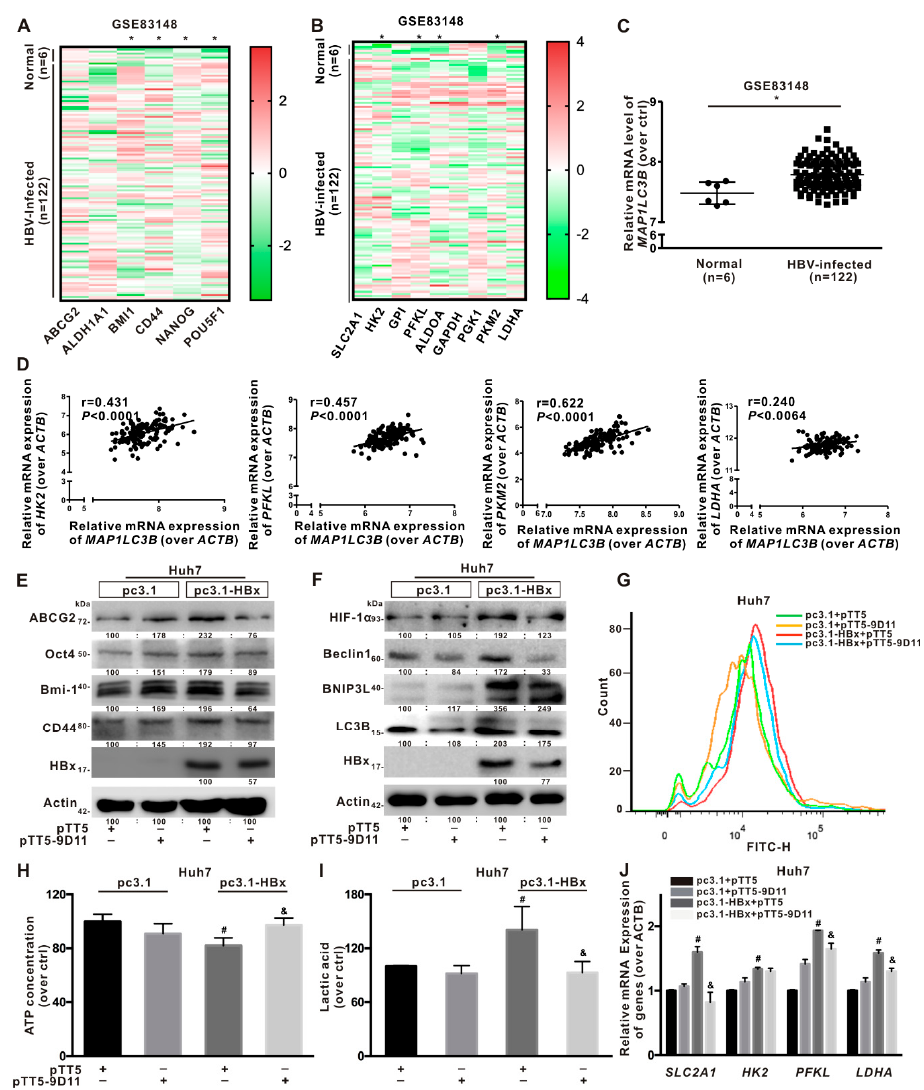
Figure 8. Anti-HBx targeting intervention to intracellular HBx inhibited the hepatocarcinogenesis associated with BNIP3L-dependent mitophagy. ( A – D ) The relative mRNA levels of indicated